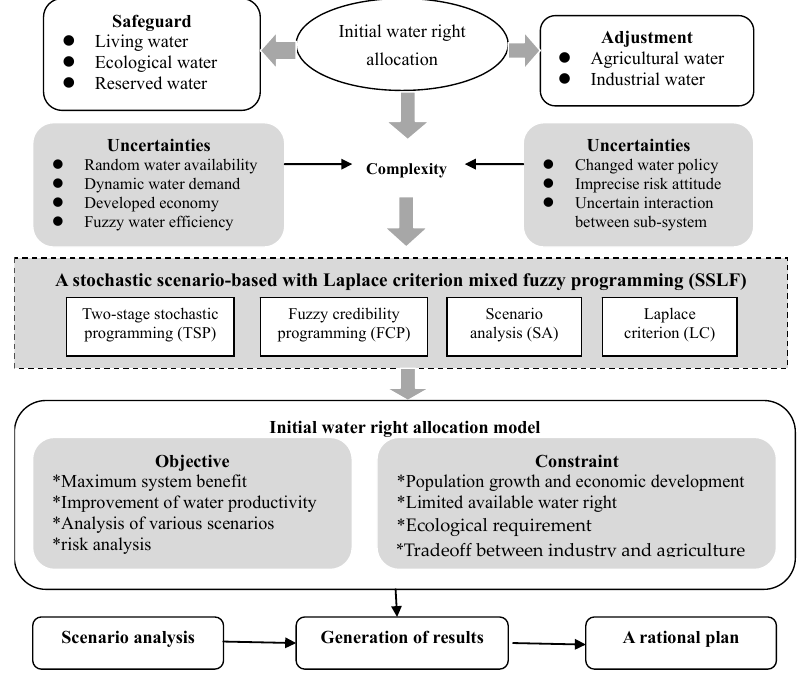
Figure 3. Framework of development of SSLF in an IWRA issue.